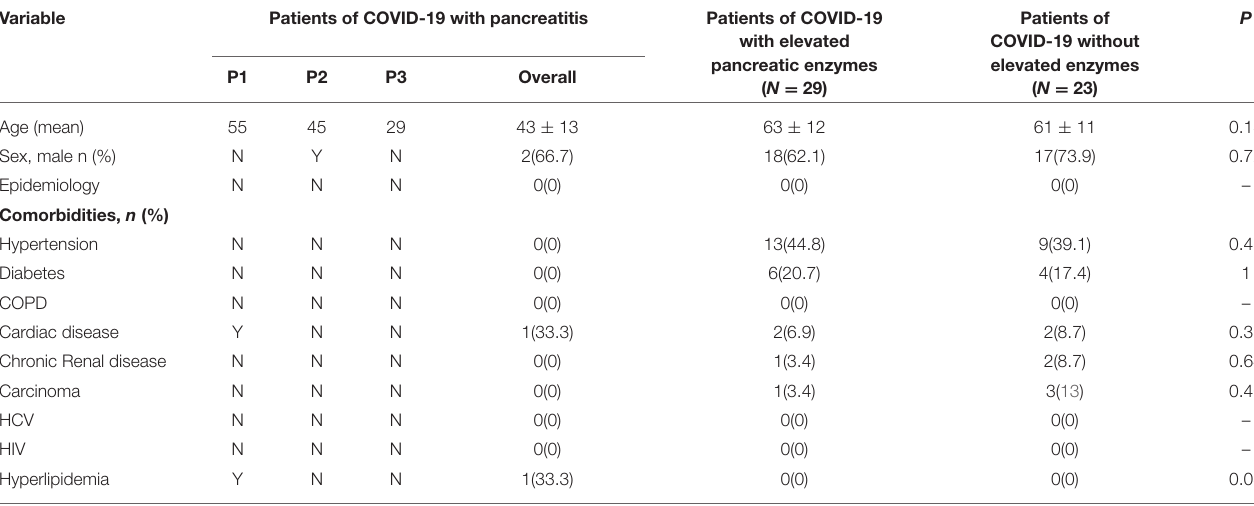
TABLE 1 | Clinical characteristics of patients with COVID-19. Variable Patients of COVID-19 with pancreatitis Patients of COVID-19